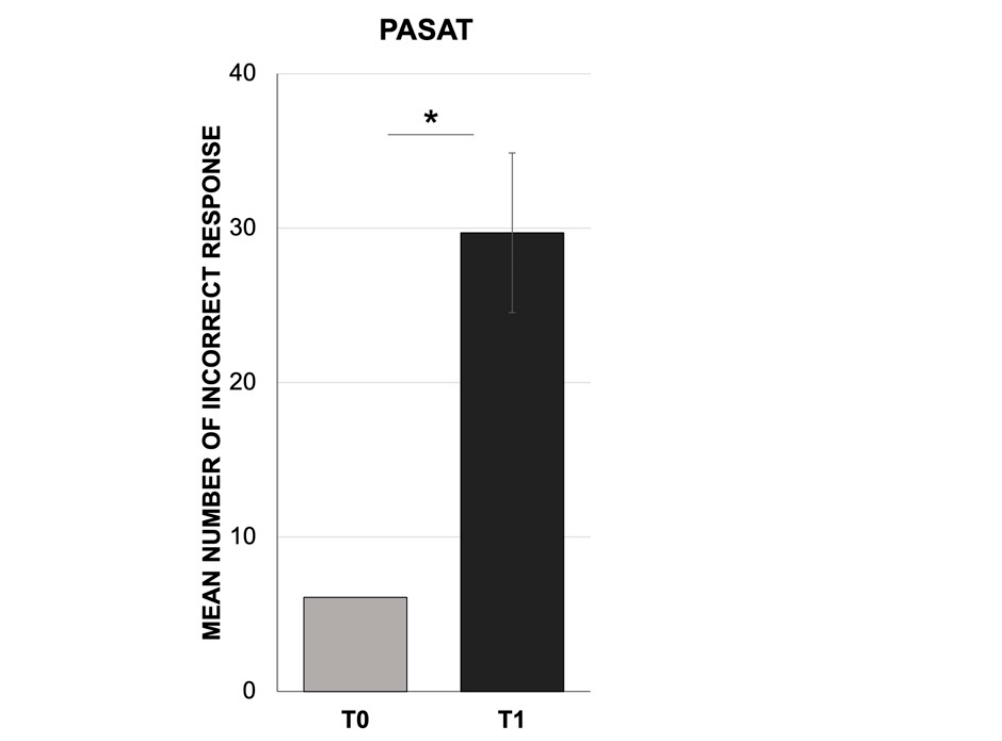
Figure 3. Mean number of incorrect responses for the working memory test (PASAT). The results collected at one month after the COVID-19 confinement (T1) compared to the normative data for the test (T0). * p < 0.001 T0 vs. T1.